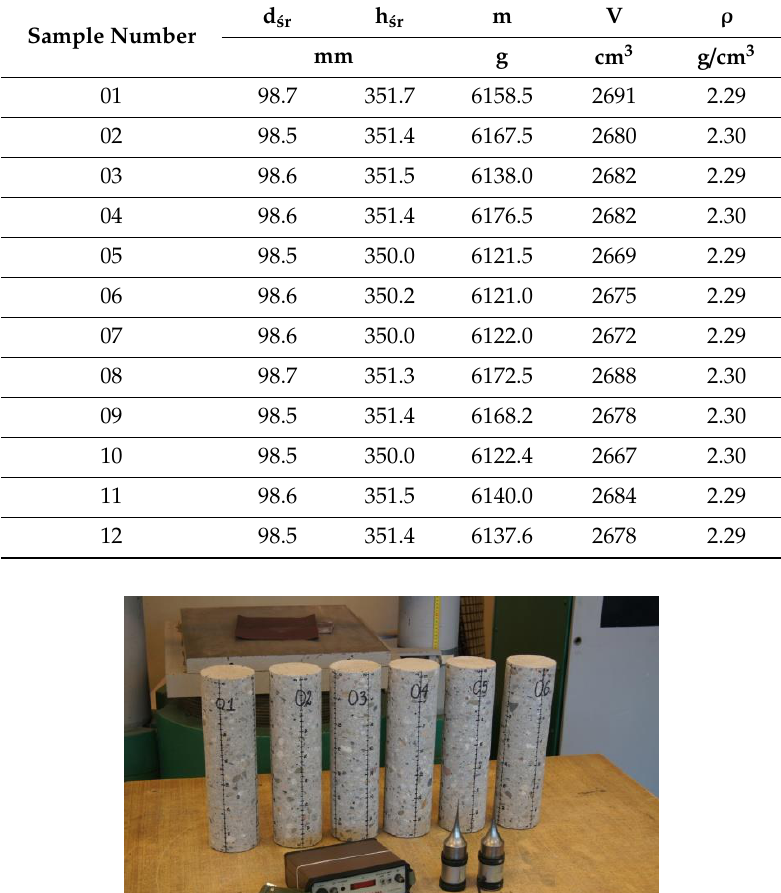
Table 1. The mean dimensions of core samples and their weight.